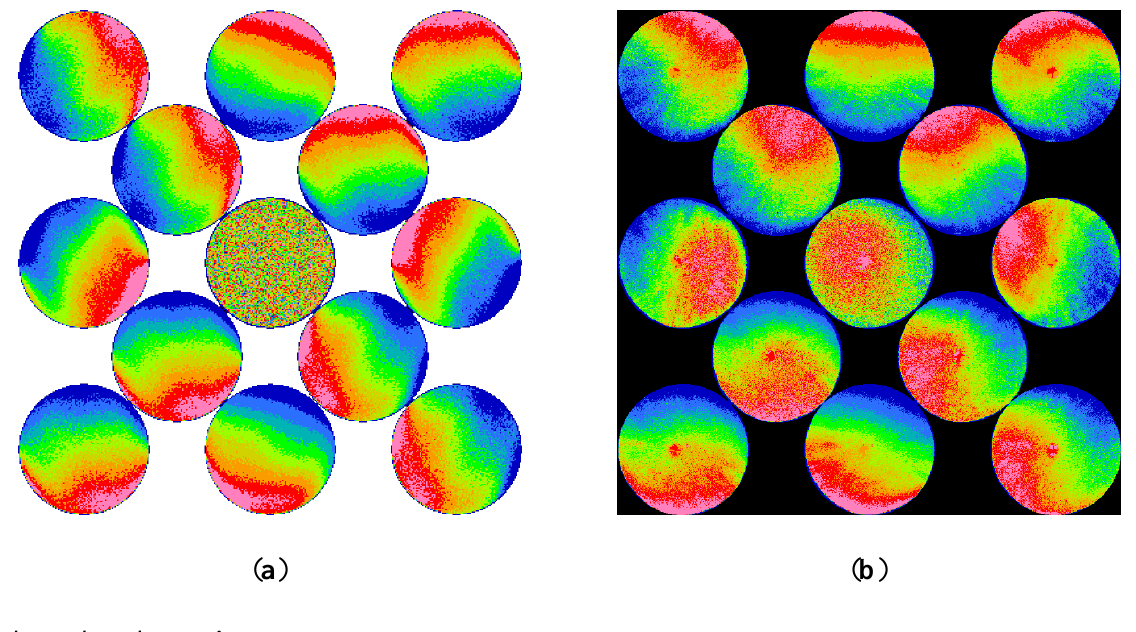
Figure 8. Comparison between ( a ) the computational result of an astigmatic eye with refractive error along the two principal meridians fall on either side of the neutralization (−3.3D). The manifest refraction of this eye was measured as −4DS + 1.75DCX82 with BCVA of 20/20, and ( b ) the experiment testing result of the same